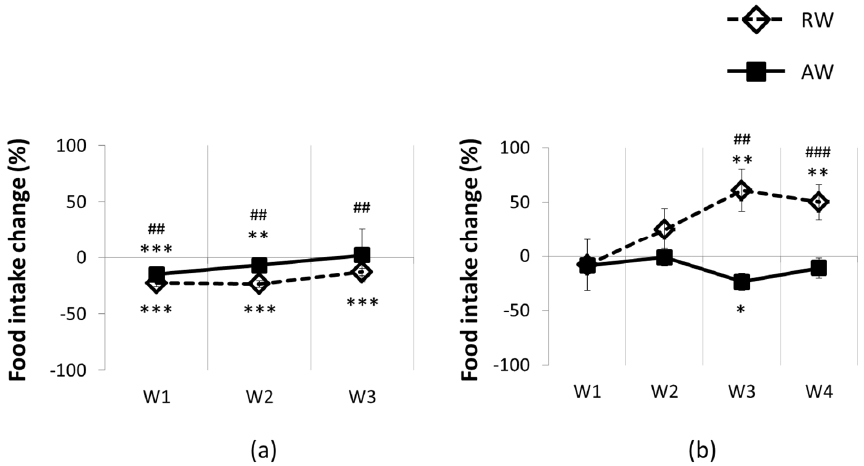
Figure 2. Food intake across one shift work period for active workers (AW) and rest-workers (RW): ( a ) 24 h food intake; ( b ) 8 h food intake (during work session). Data are shown as percentage change relative to baseline. Error bars indicate SEM. W1–4 indicates work days 1 to 4. W4 not included in 24 h food intake due to missing measurements. * p < 0.05; ** p < 0.01; *** p < 0.001, compared to